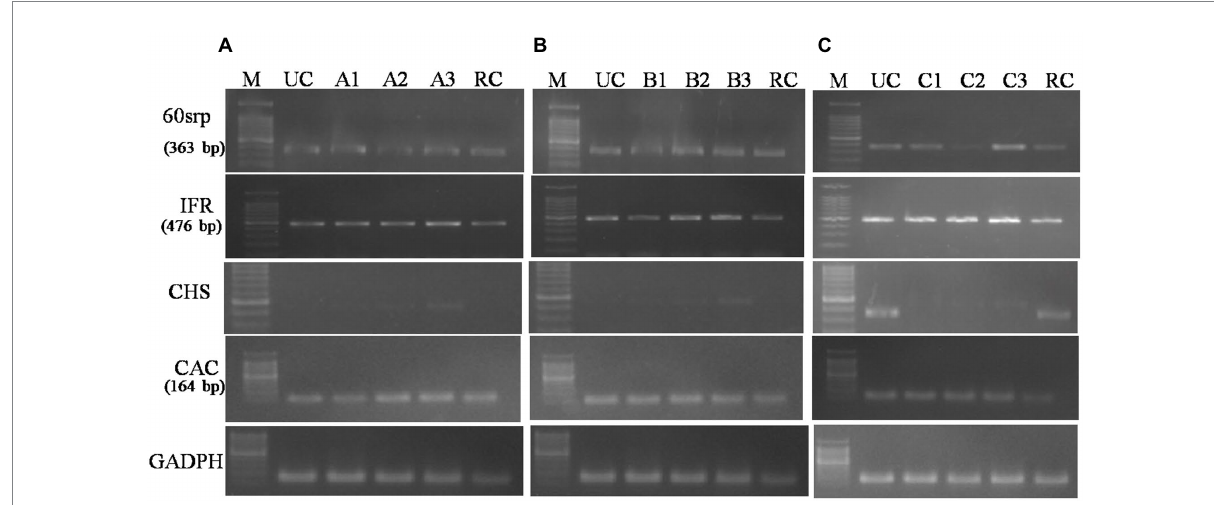
FIGURE 8 Effect of bacterial endophytes inoculation on expression of PR genes ( A , R. solani pre-challenged; B , S. rolfsii pre-challenged; C , F. oxysporum f. sp. ciceri pre-challenged) Treatment details: UC-Uninoculated (negative control in which neither pathogen nor bacterial strain inoculated). A1, B1, C1 – Positive control of R. solani , S. rolfsii, and F. oxysporum f. sp. ciceri , respectively in which only pathogen inoculated. A2, B2, C2 – Respective pathogen + B. subtilis strain TRO4 inoculated. A3, B3, C3 – Respective pathogen + B. subtilis strain CLO5 inoculated. RC, Resistant